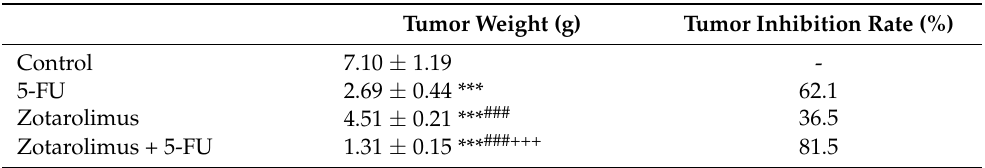
Figure 1. Relative volume of tumors. ( a ) Photographs of tumors excised after sacrifice on day 28. ( b ) Volumes of HCT- 116 tumor masses from BALB/c nude mice administered different treatments: control (saline), 5-FU (50 mg/kg/week), zotarolimus (2 mg/kg/day), and zotarolimus (2 mg/kg/day) combined with 5-FU (50 mg/kg/week). All data are presented as mean ± standard deviation, n = 8 per group. ** p < 0.01 and *** p < 0.001 compared with the control group. ### p < 0.001 compared with the 5-FU-treated group. +++ p < 0.001 compared with the zotarolimus-treated group. All treatments were initiated on day 7 when the tumors were detected. Table 1. Weight of tumors from BALB/c nude mice after